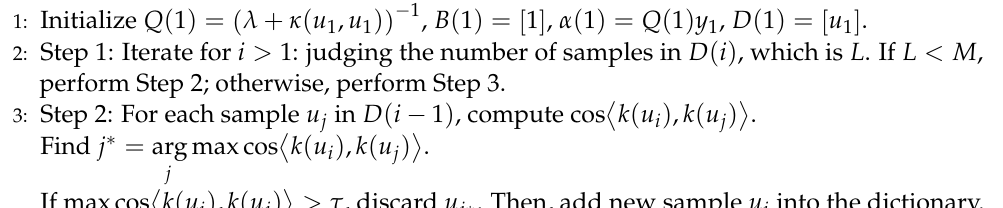
Algorithm 2 Proposed SSW-KRLS